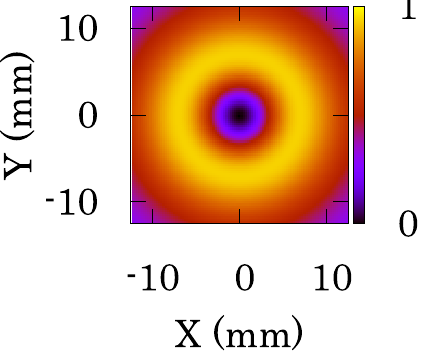
Figure 5. Spatial distribution of the second harmonic X-rays in the case of Brookhaven National Laboratory calculated by Eq. (35). The parameters are γ 0 = 128, λ 0 = 10.6 μ m, a 0 = 0.6, n = 2, and z = 1.85